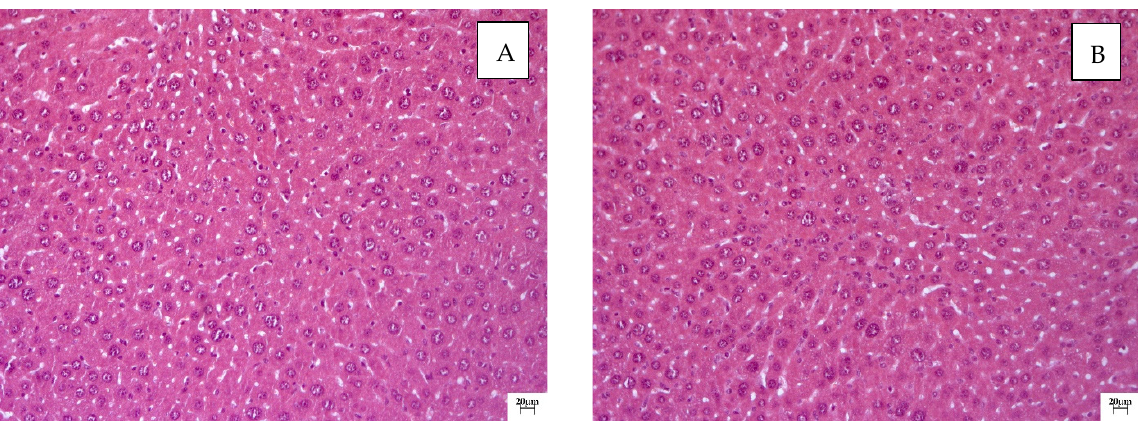
Figure 4. Histological examination of mouse livers treated with QS-528 at doses of 120 and 150 mg/kg for 3 weeks: ( A ) Mice treated with QS-528 at a dose of 120 mg/kg. The absence of heterogeneity of hepatocytes and fatty degeneration indicates the normalization of reparative processes. Staining with hematoxylin–eosin, ×200. ( B ) Mice treated with QS-528 at a dose of 150 mg/kg. Improvement in the structure of hepatocytes, lack of heterogeneity and dystrophy. Staining with hematoxylin–eosin, ×200.